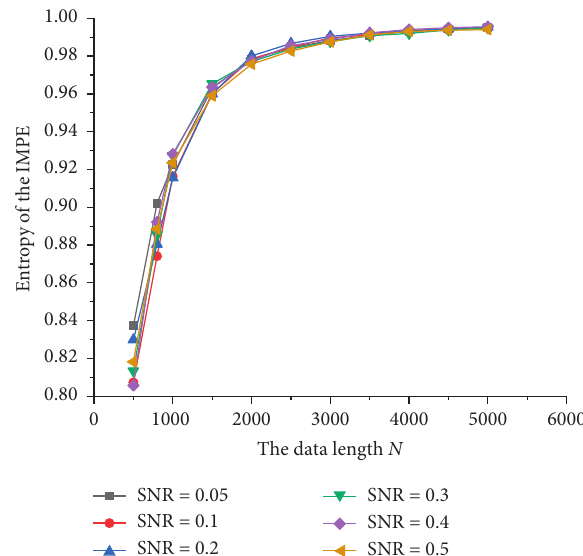
Figure 5: Signal entropy values with different white